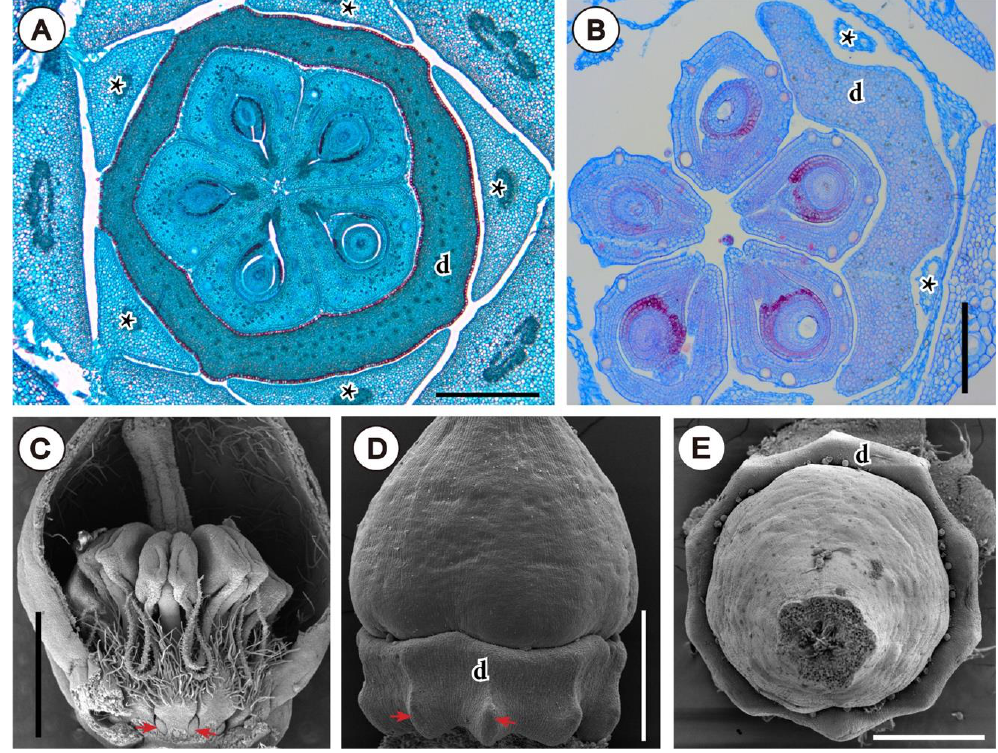
Figure 11. Inferred effect of spatial interaction of organs within young flower. ( A , B ) Photomicro- graphs of microtome transections of floral buds of Rutaceae, close to the floral base. ( A ) Detail of Conchocarpus macrocarpus (Engl.) Kallunki & Pirani, note polygonal shape of nectary and five protu- berances between filaments. ( B ) Detail of Ertela bahiensis (Engl.) Kuntze, at mid-level of ovary; note outline of unilateral disc. ( C – E ) SEM micrographs of flowers of Arctostaphylos pungens (Ericaceae). ( C ) Bud longitudinally opened; arrows indicate basal protuberant part of nectary formed between filaments. ( D ) Lateral view of ovary and nectary (stamens removed), with arrows indicating same region as in C. ( E ) Same as in D, frontal view, showing decagonal outline of nectary disc. Abbrevia- tions: asterisk, filaments; d, nectary disc. Scale bar in A, D, E = 500 μm , in B = 200 μm , in C = 1 mm. 4. Non-Intrusive Visualization of Flower Development and the Outcome of Mechani- cal Forces As shown above, there are many structural interactions that result in mechanical forces influencing the development of the entire flower or a particular whorl or organ. However, one major drawback in studying the spatial relations between organs is the ne- cessity to dissect or section the flower to usually study only the outcome of mechanical forces. Direct observations of development are naturally limited to the external parts of the developing flower (usually bracts, bracteoles or perianth organs). The often destruc- tive and indirect way of visualization still allows for an interpretation. However, the